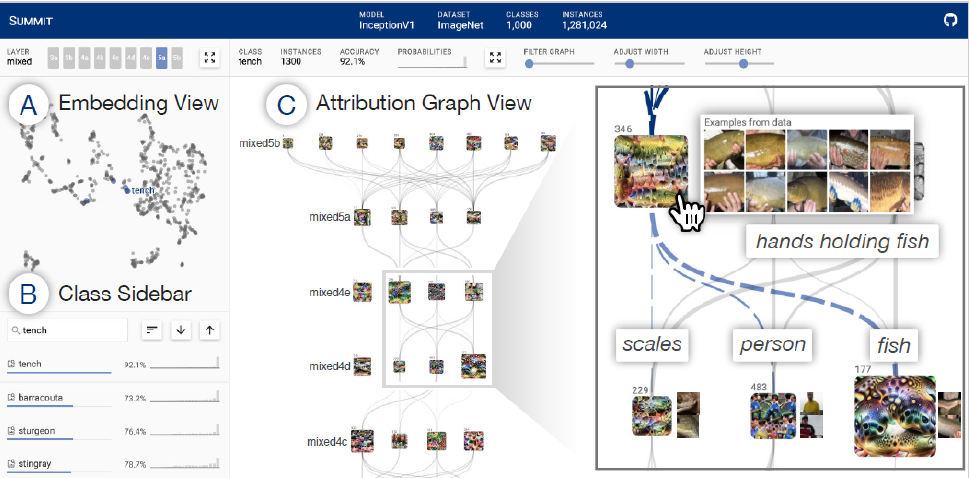
Figure 14. Summit [98] visualizes what features a Deep-Learning model has learned and how those features are connected to make predictions. The Embedding View ( A ) shows which classes are related to each other; the Class Sidebar ( B ) is linked to the embedding view, listing all classes sorted in several ways; the Attribution Graph ( C ) summarizes crucial neuron associations and substructures that contribute to a model’s